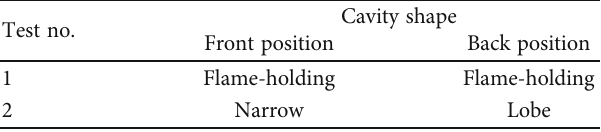
Table 2: The shape of the cavity shape in test case. Test